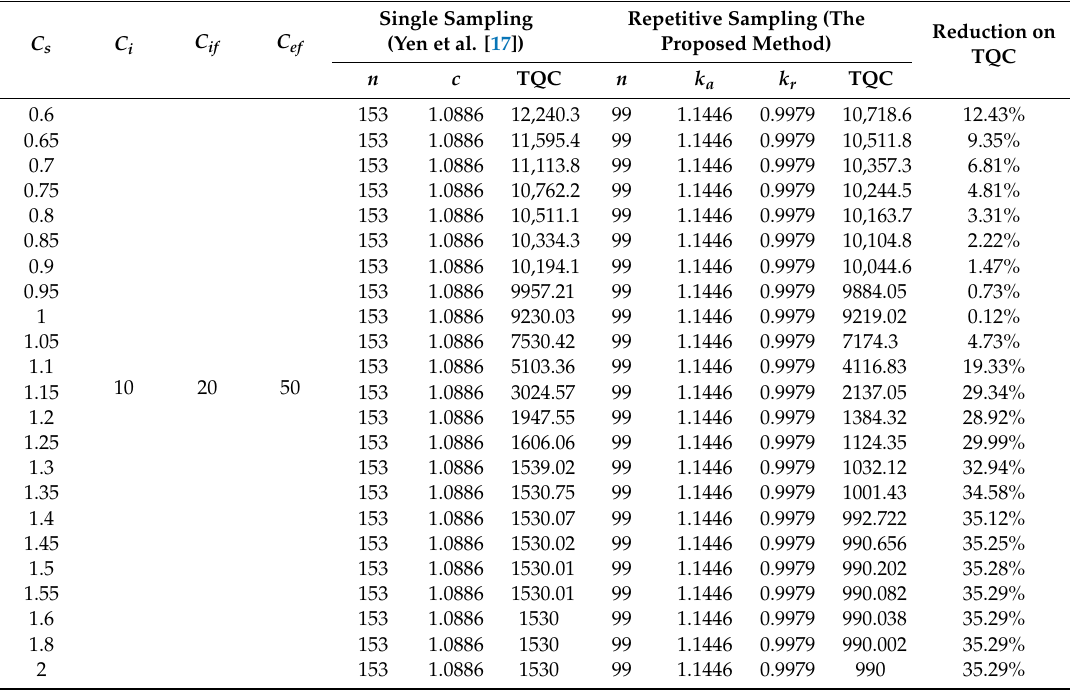
Table 2. Sensitivity analysis of TQC for C S